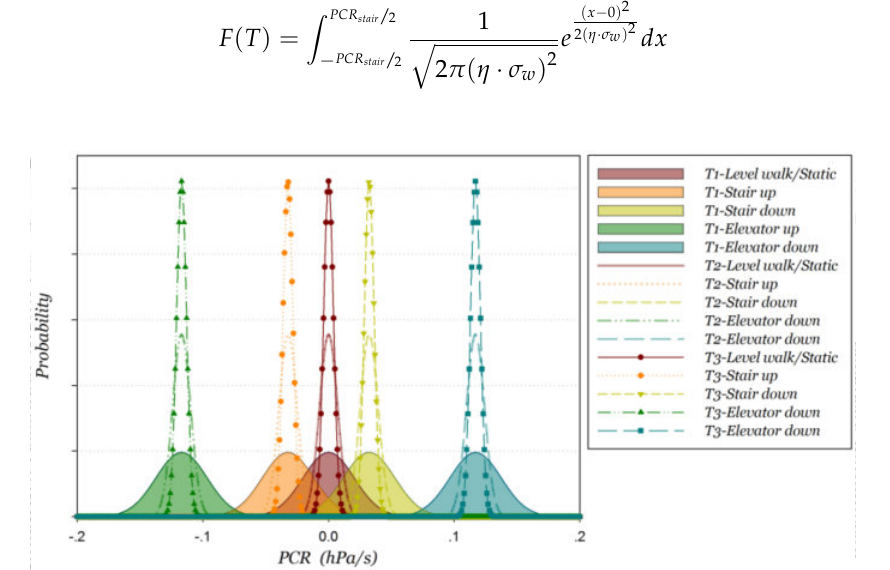
Figure 1. PCR probability distribution of different time-window lengths at different motion